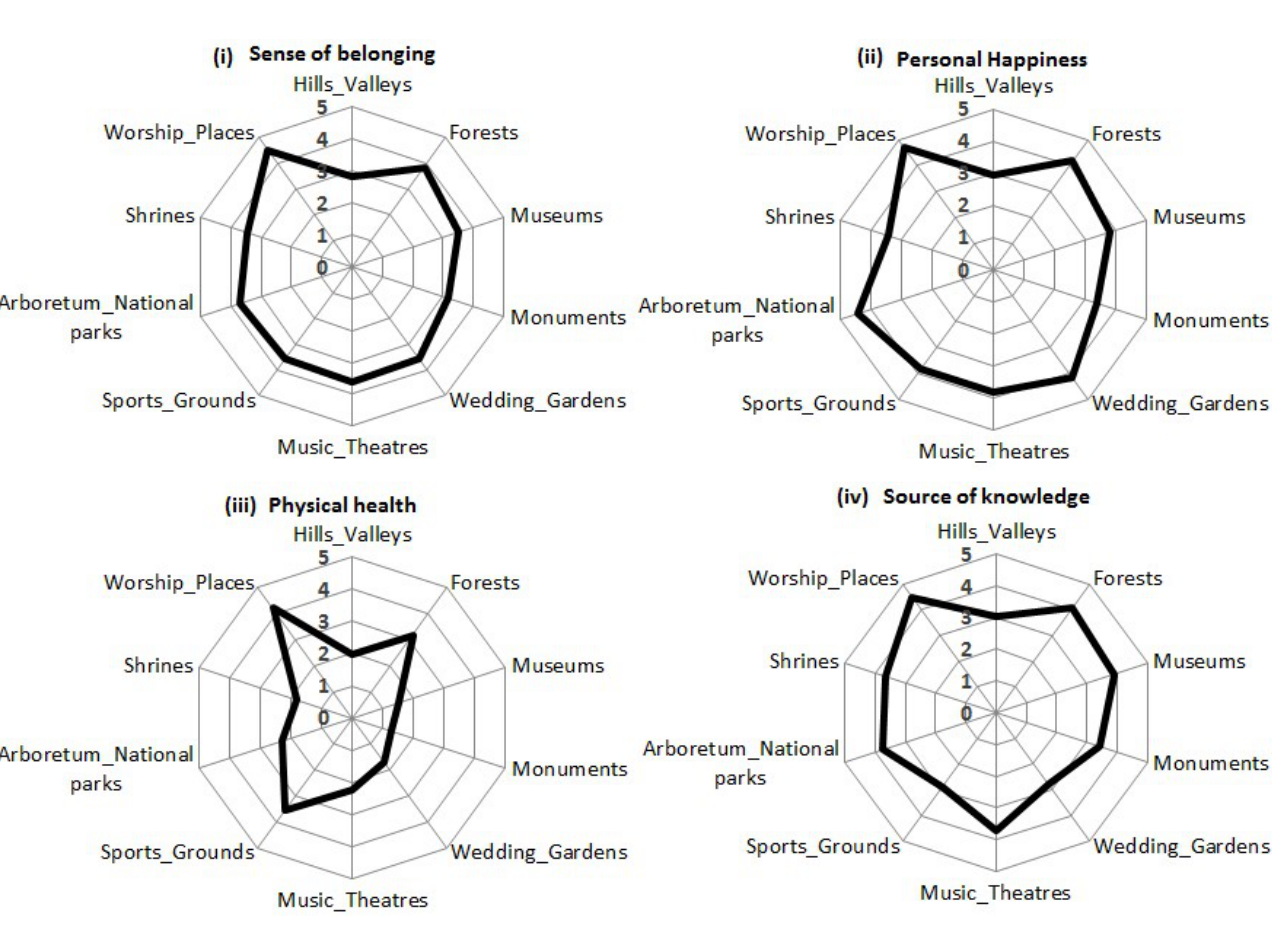
Figure 4: Qualitative importance of selected CES indicators (i-v) in relation to selected constituents of human wellbeing and their comparisons (vi),